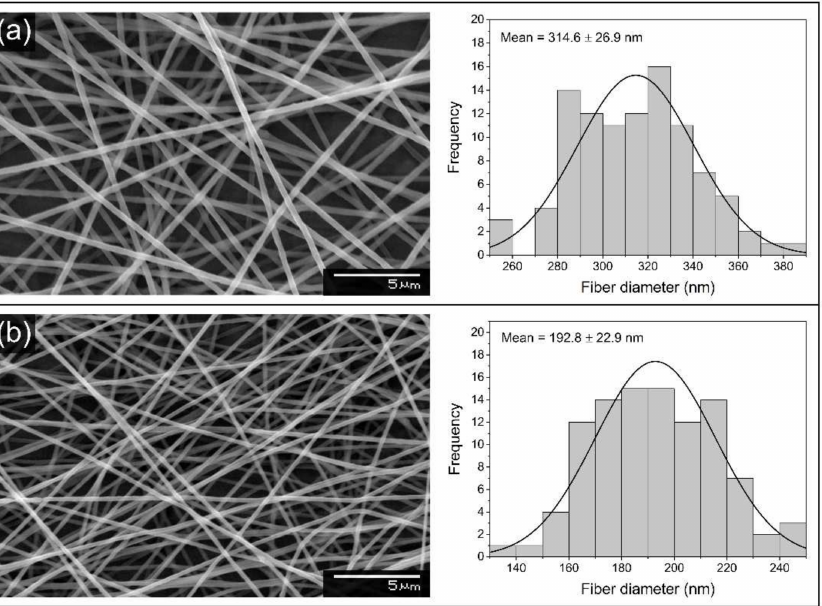
Figure 2. SEM images and histograms of the fiber diameter distribution of unloaded PEO ( a ) and NaClO 2 -loaded PEO ( b )